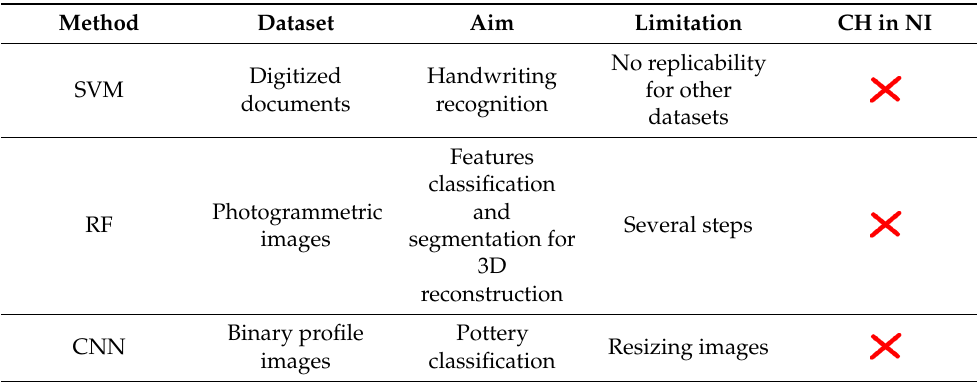
Table 2. ML and DL techniques applied in CH imaging.